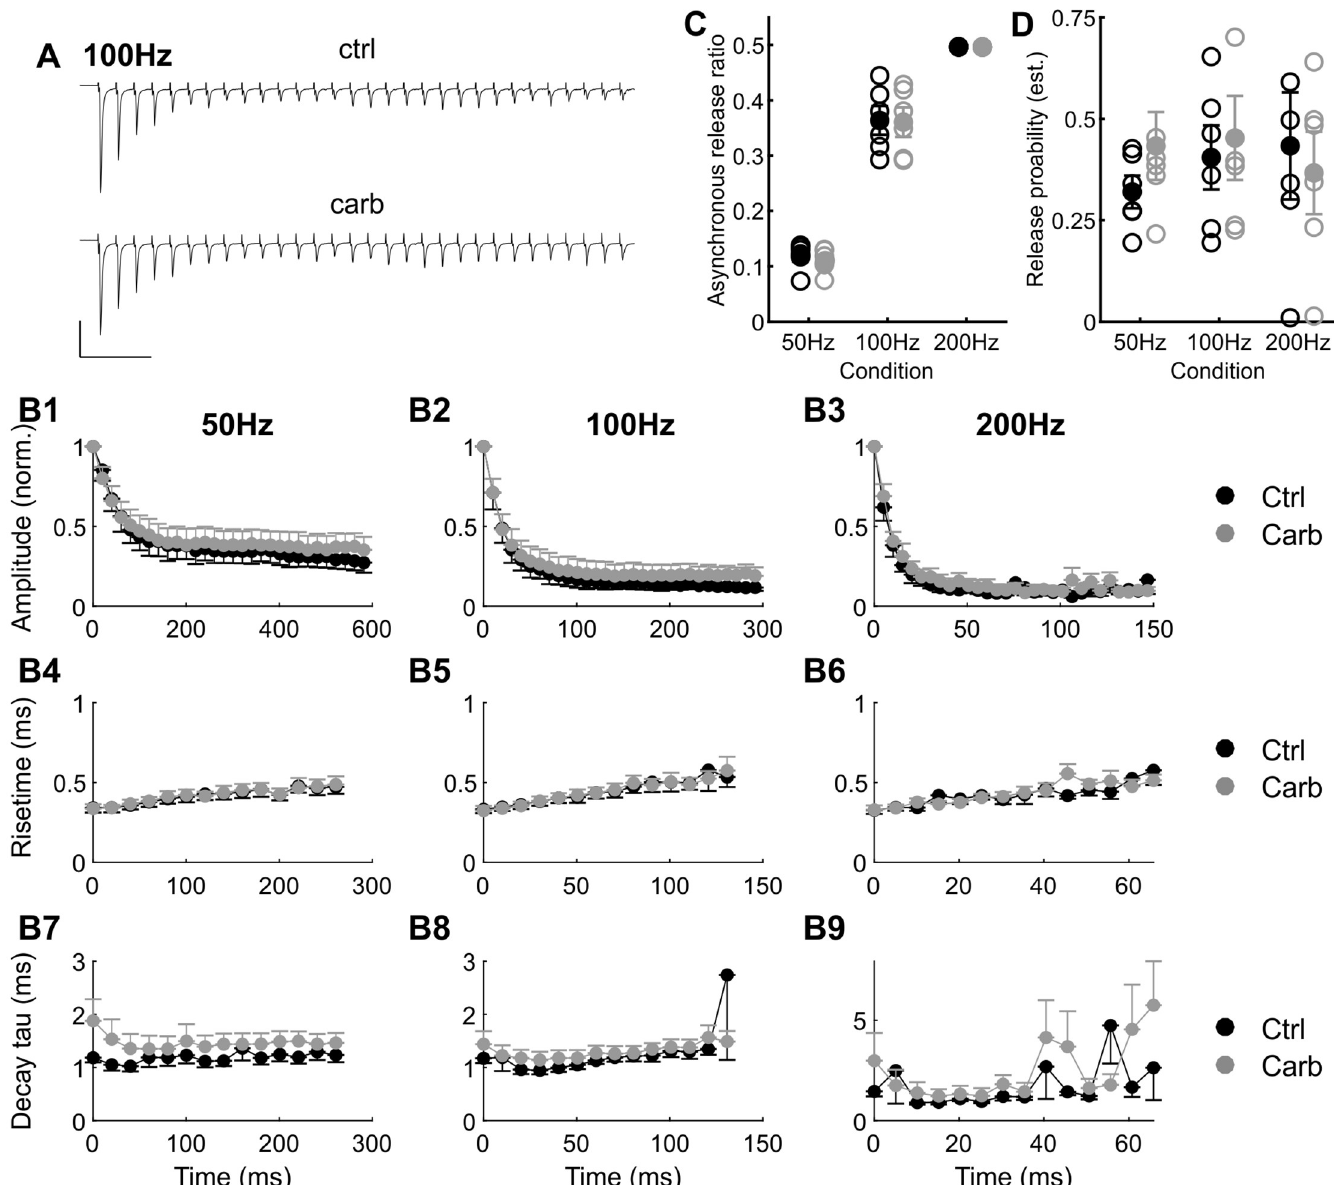
Fig 7. No effect of carbachol on evoked EPSCs and short term depression. (A) Example traces of recorded eEPSCs at 100Hz during the 30 stimulus train in control (ctrl) condition (upper part) and in presence of carbachol (carb, lower part); scale: 50 ms/3 nA. In both cases, a strong short-term depression was observed. (B1-3) Normalized average amplitude of eEPSCs for 50 Hz (B1), 100 Hz (B2) and 200 Hz (B3) compared between control (black) and carbachol (grey) conditions. No significant effects of carbachol were found. n = 6. (B4-6) Rise time of eEPSCs for 50 Hz (B1), 100 Hz (B2) and 200 Hz (B3) compared between control (black) and carbachol (grey) conditions. No significant effects of carbachol were found. n = 6. (B7-9) Decay time constant of eEPSCs for 50 Hz (B1), 100 Hz (B2) and 200 Hz (B3) compared between control (black) and carbachol (grey) conditions. No significant effects of carbachol were found. n = 6. (C) Estimated amount of asynchronous release (given as the amount of area under the curve of the second half of the stimulus duty cycle, divided by the area under the curve of the first half of the stimulus duty cycle) steeply increased with stimulus frequency but is not affected by carbachol. Please note: individual values (open circles) for the 200Hz condition masked by the marker for the group mean (closed circles). (D) The estimated release probability of the endbulb of Held (given as the amount of current released by the first EPSC divided by the estimated size of the readily-releasable pool) does not significantly depend on stimulus frequency or carbachol.